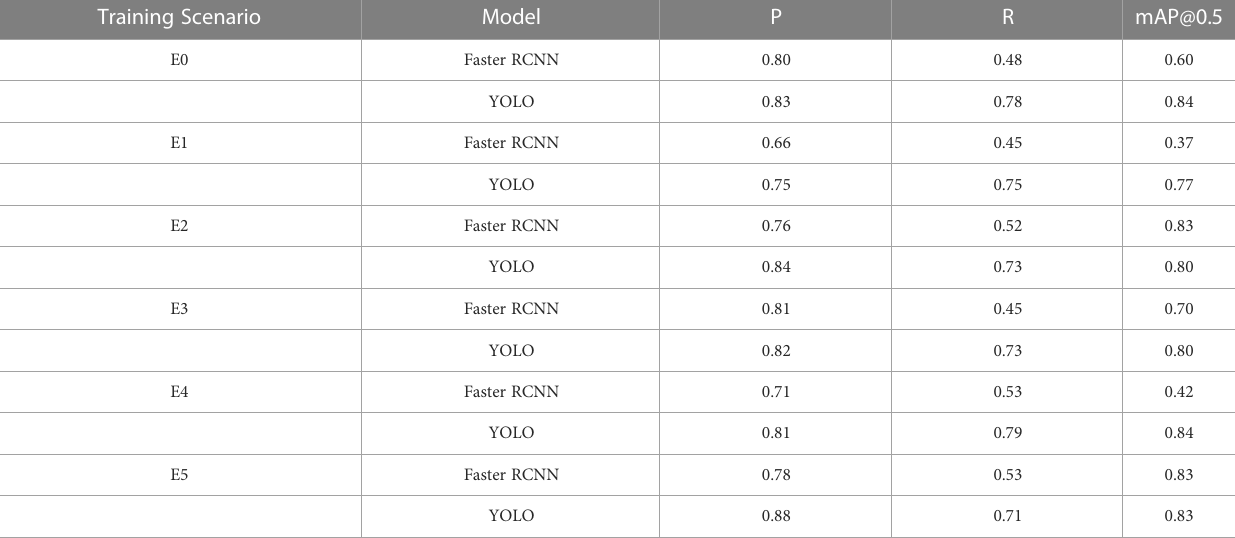
TABLE 3 Performance metrics for each scenario computed over the training datasets (see Table 1